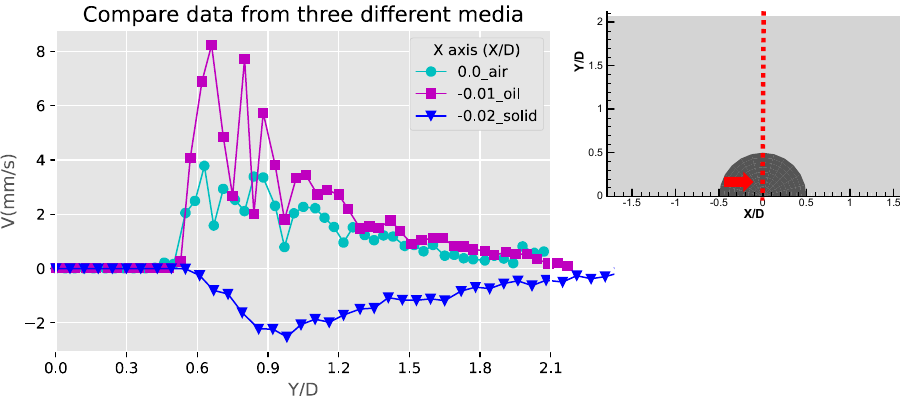
Figure 12. Comparison of the Y-component velocity (V) profiles at the centerline of the obstructions (X/D = 0).